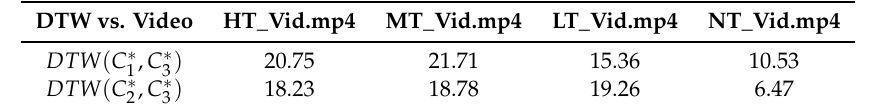
Table A1. Omnidirectional Traffic Curve Comparison: C ∗ Human Count (ground truth); the video frame size was 640 × 480, the interrogation window size was 90; and the interrogation window overlap was 60%.